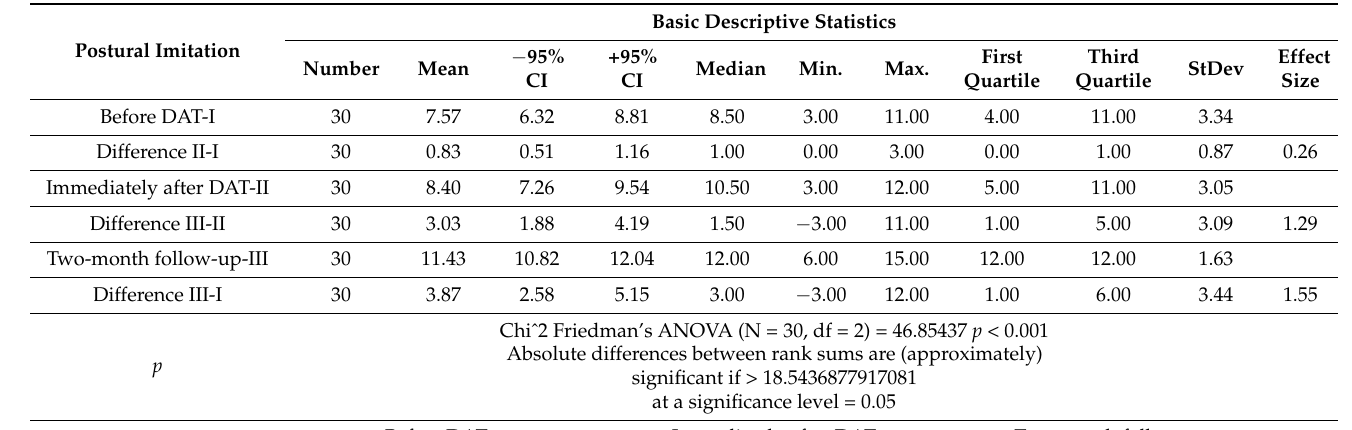
Table 3. Postural imitation—analyses of the measurements performed over